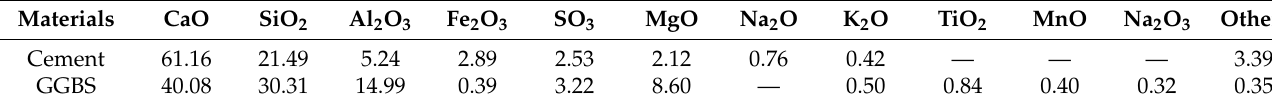
Table 1. Main chemical compositions of raw materials (mass fraction) (%).